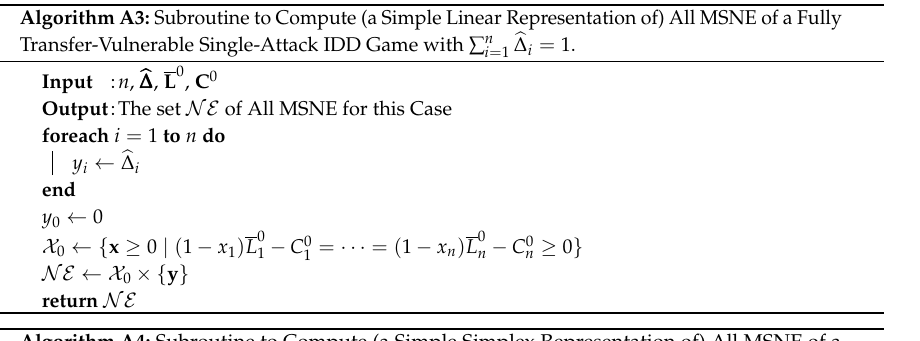
Algorithm A4: Subroutine to Compute (a Simple Simplex Representation of) All MSNE of a Fully Transfer-Vulnerable Single-Attack IDD Game with ∑ n i = 1 (cid:98) ∆ i >